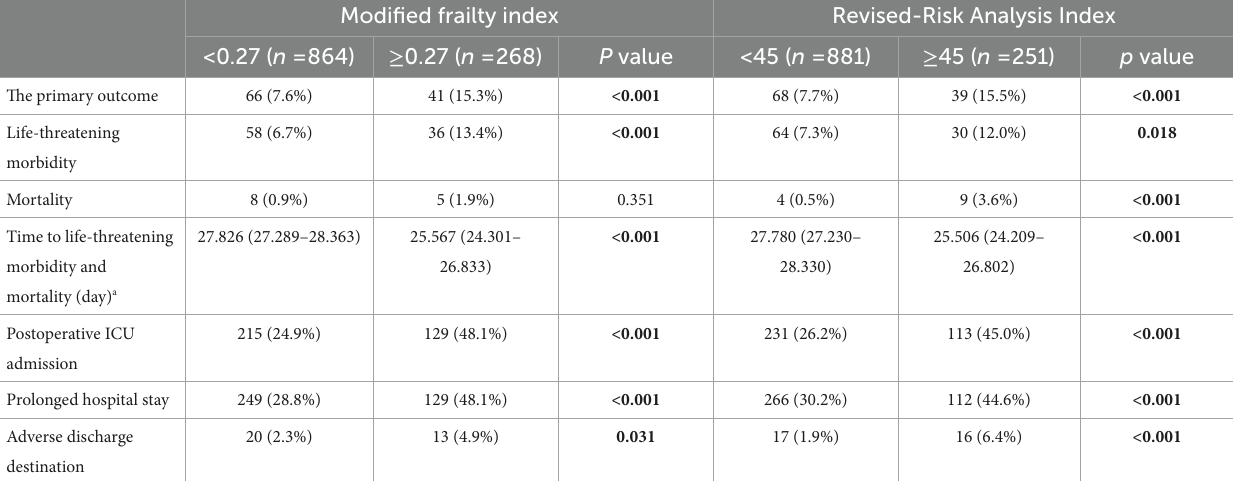
TABLE 2 Postoperative outcomes according to